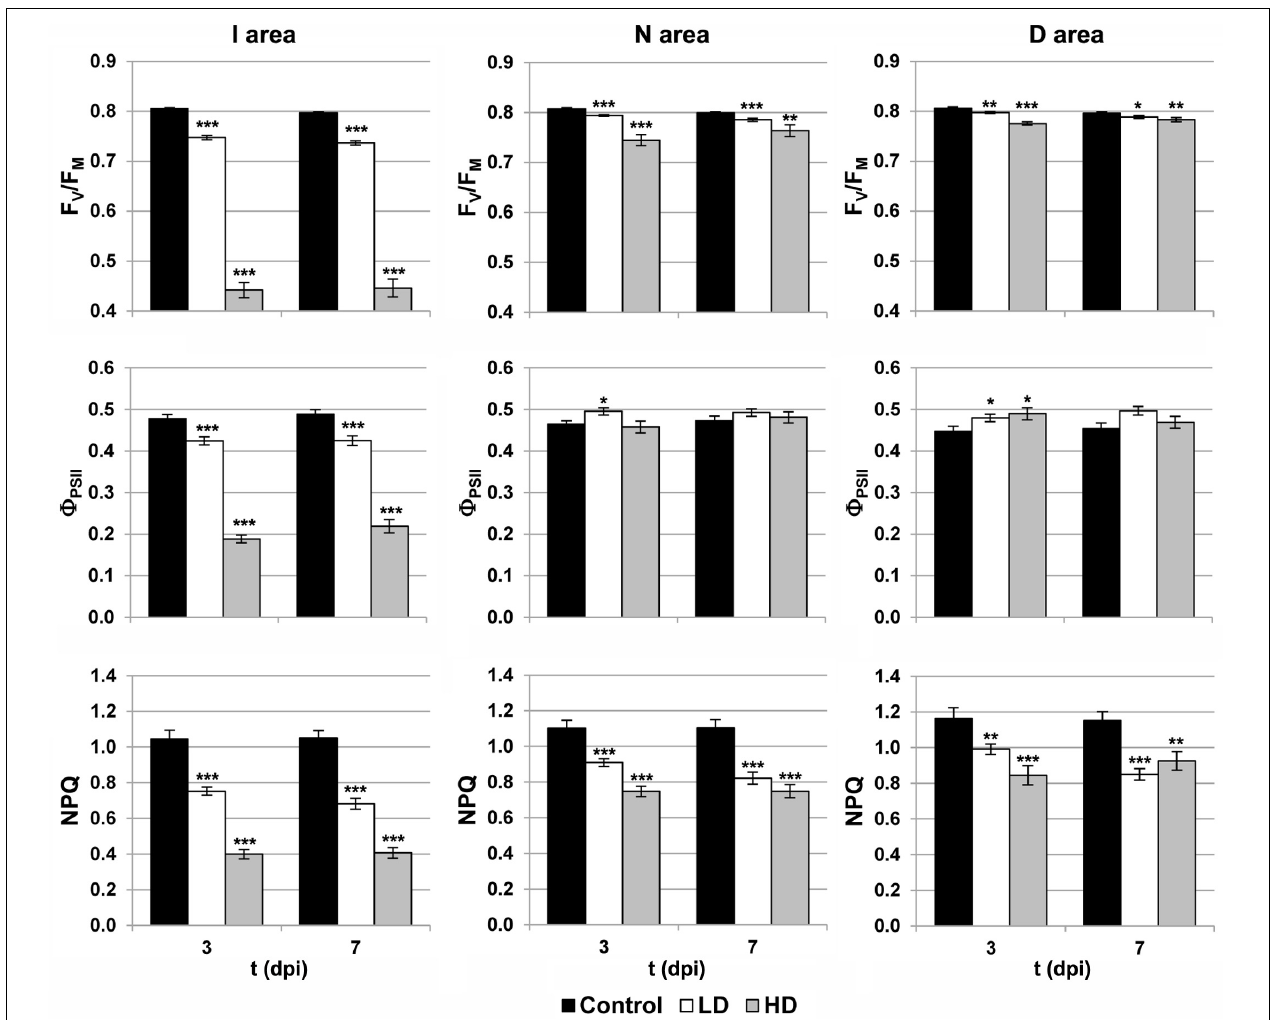
FIGURE 2 | Parameters obtained by variable chlorophyll fluorescence imaging in the I (inoculated), N (neighboring), and D (distant) areas of treated leaves. F V /F M , maximum quantum efficiency of photosystem II; (cid:56) PSII , effective quantum yield of photosystem II; NPQ, non-photochemical quenching; dpi, days post-inoculation; LD and HD, low and high bacterial dose (10 4 and 10 6 colony forming units ml − 1 , respectively). ∗ p < 0.1, ∗∗ p < 0.01, and ∗∗∗ p < 0.001, according to Student’s t